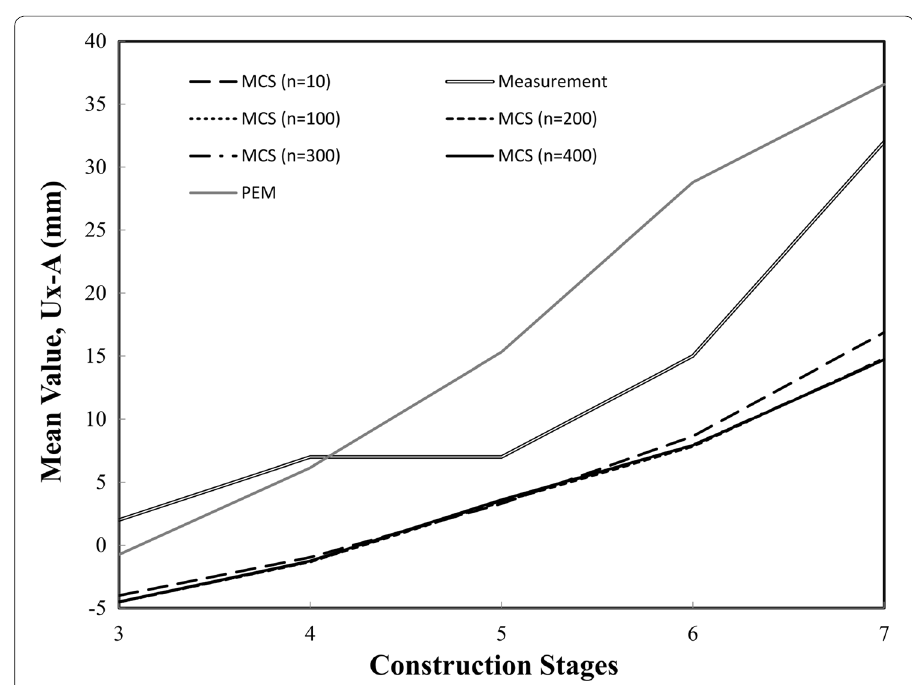
Fig. 8 Mean values of U x